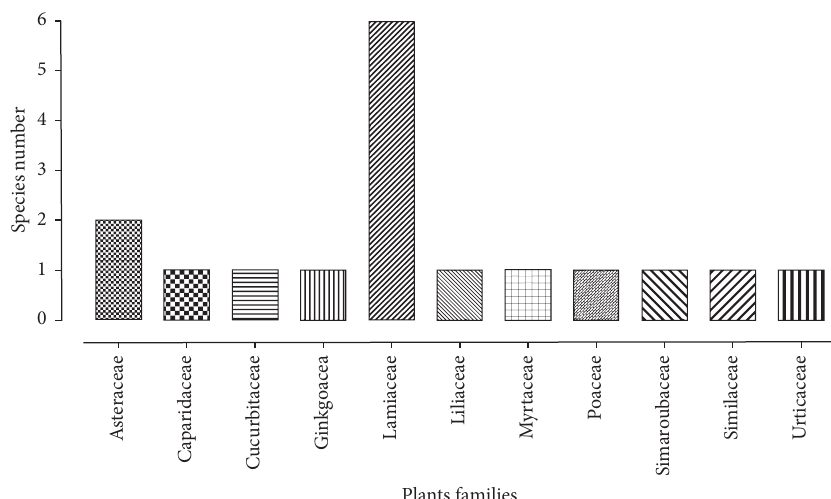
Figure 2: Repartition of the different antigout plant